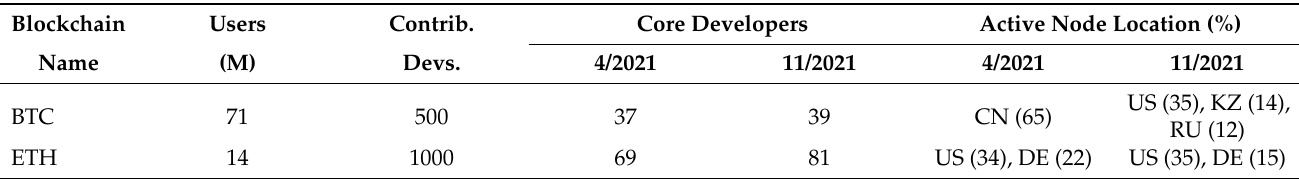
Table 6. BTC and ETH autonomy and belonging related